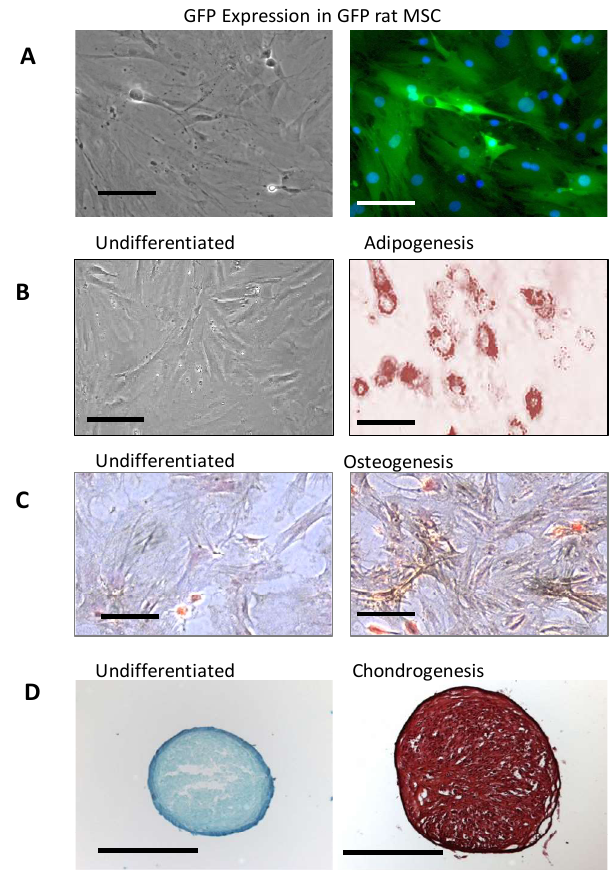
Figure 1. Characterization of GFP-rat mesenchymal stem cells (rMSC) in vitro. ( A ) Expression of green fluorescent protein (GFP) in rMSC from bone marrow of Lewis GFP+ transgenic rats in culture. ( B – D ) Differentiation of GFP rat MSCs under adipogenic conditions demonstrated by Oil-Red-O staining ( B ) and osteogenic conditions after staining calcium deposition (dark particles) by the method of von Kossa ( C ), and chondrogenic differentiation in pellet culture format after sectioning and staining with safranin O ( D ). Multilineage differentiation was tested on three different occasions by two different researchers. The GFP expression continues in the differentiated MSCs, but its visualization is not seen well in the stained samples. Panels A, B, and C, Bar = 100 µm. Panel D, Bar = 1 mm.